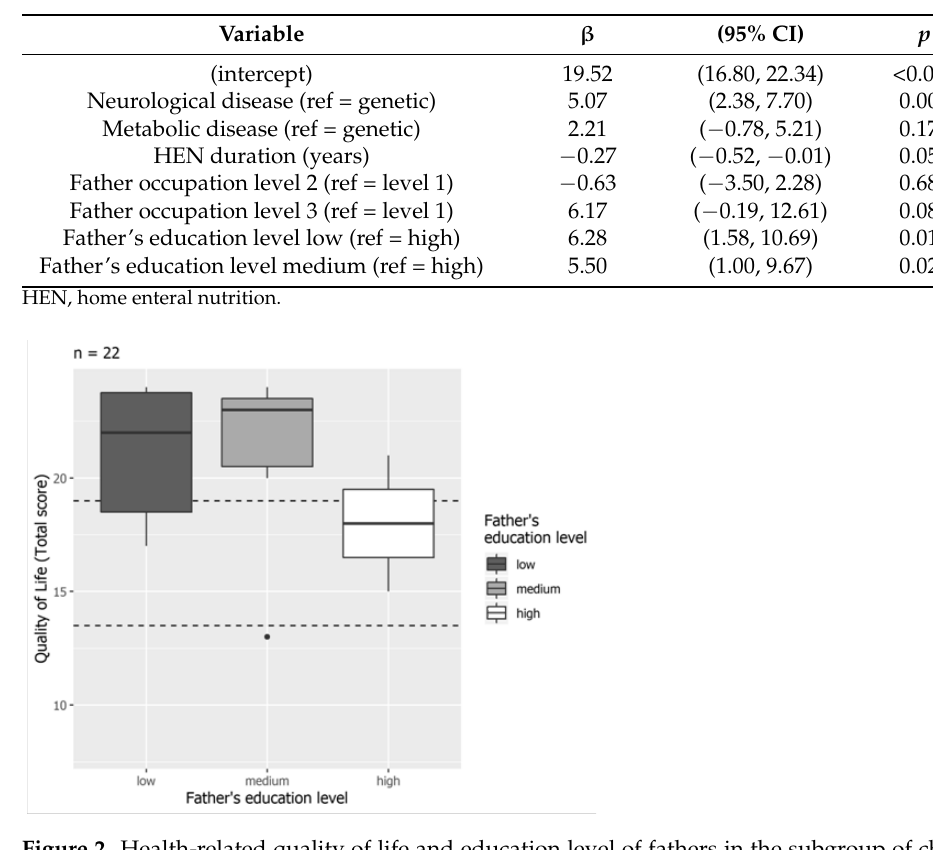
Figure 1. Health-related quality of life and education level of mothers. Table 4. Multiple Poisson regression model estimates for health-related quality of life score. Results for subgroup analysis (both parents as caregiver).